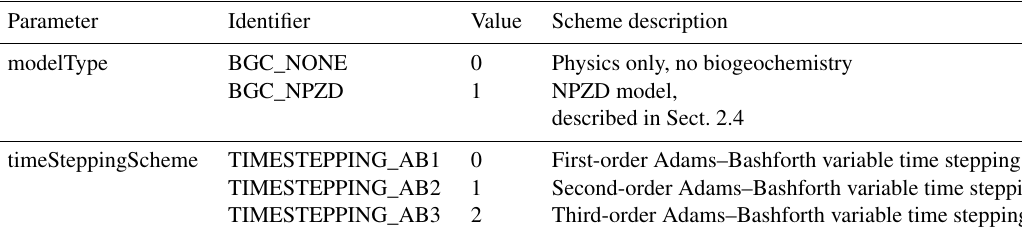
Table 4. MAMEBUS numerical scheme options and